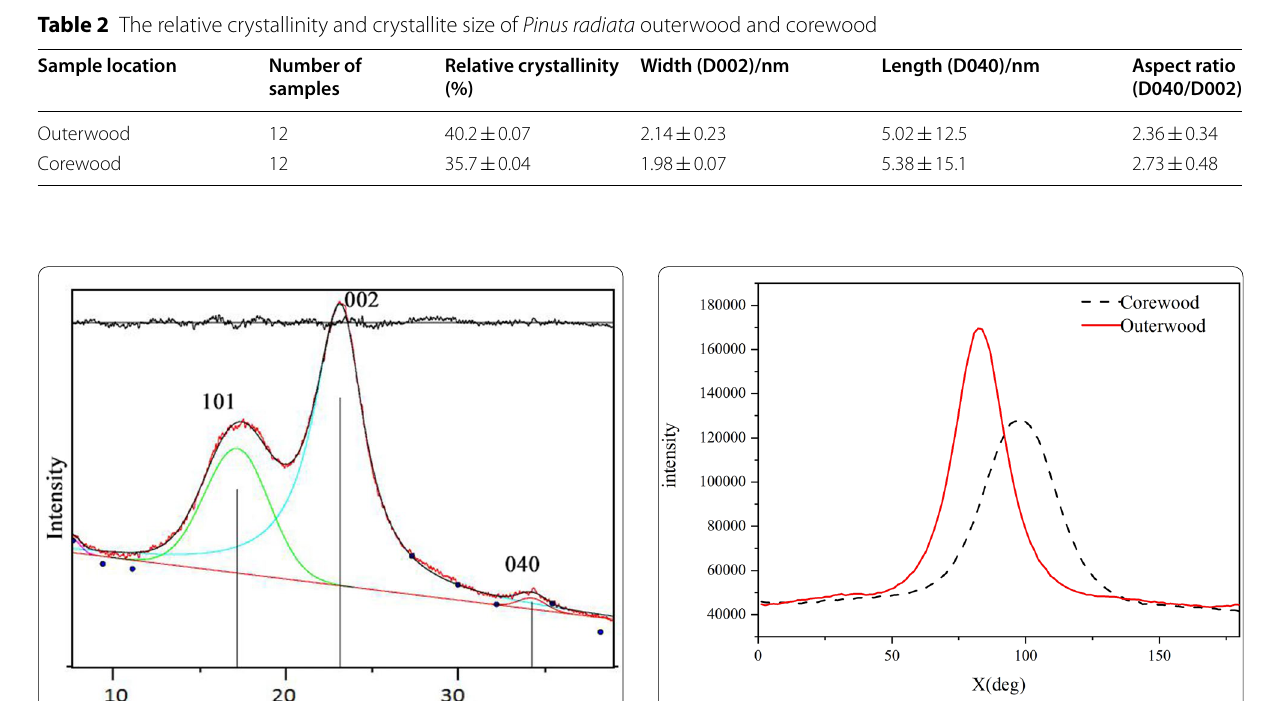
Fig. 5 X‑ray of MFAs of the Pinus radiata corewood and